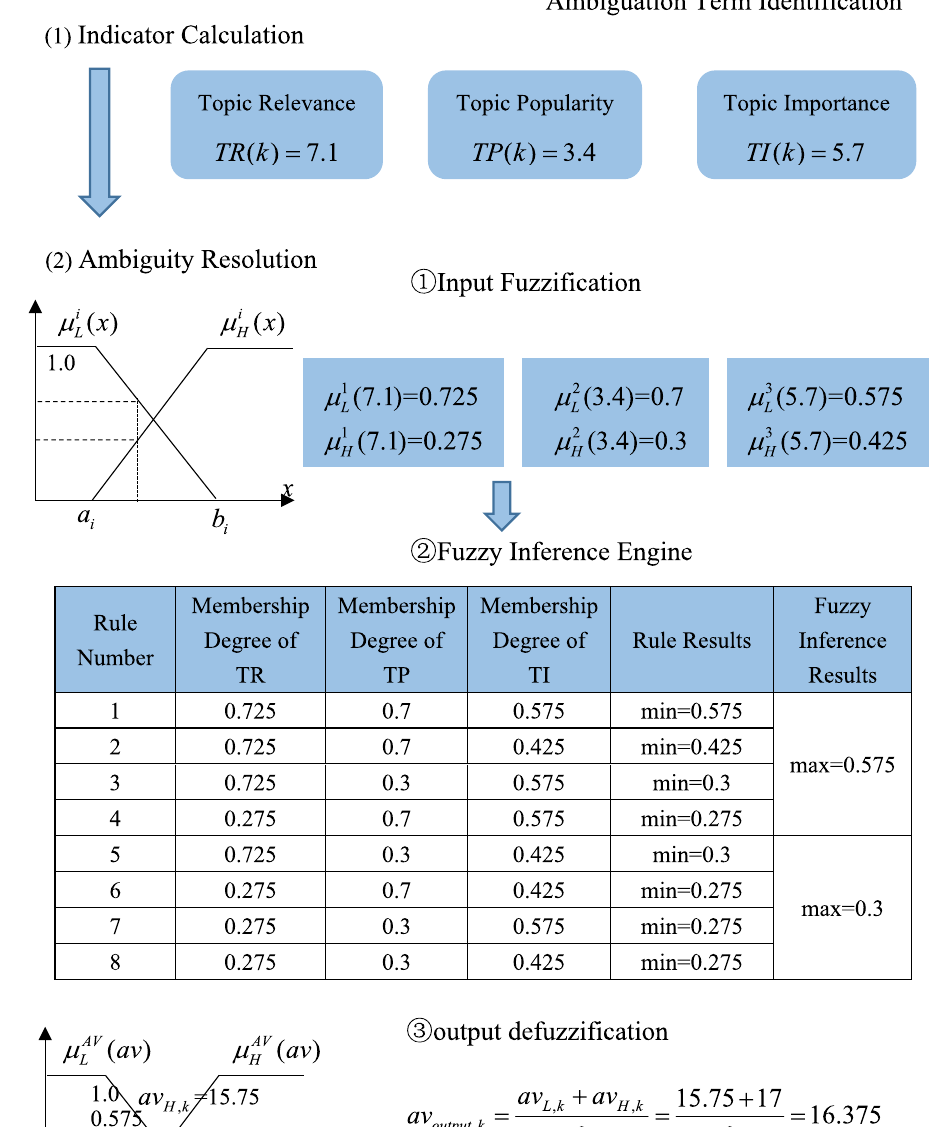
Fig. 3 An example of the ambiguation term